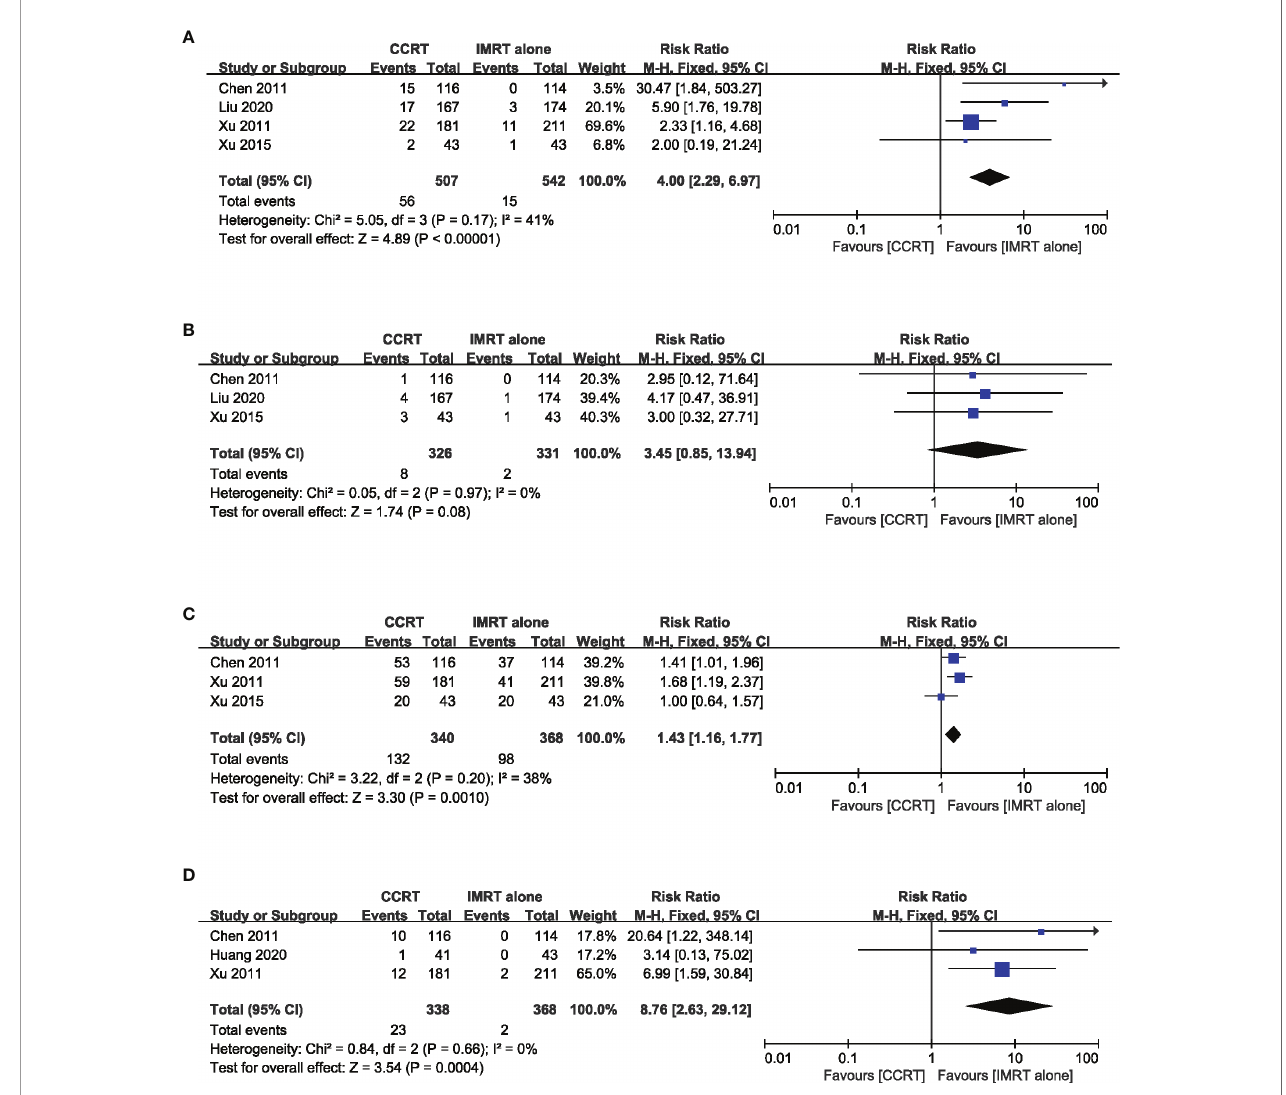
FIGURE 6 | Forest plot of the meta-analysis regarding grade 3 – 4 leukopenia (A) , thrombocytopenia (B) , mucositis (C) , and gastrointestinal reactions (D) with CCRT vs. IMRT